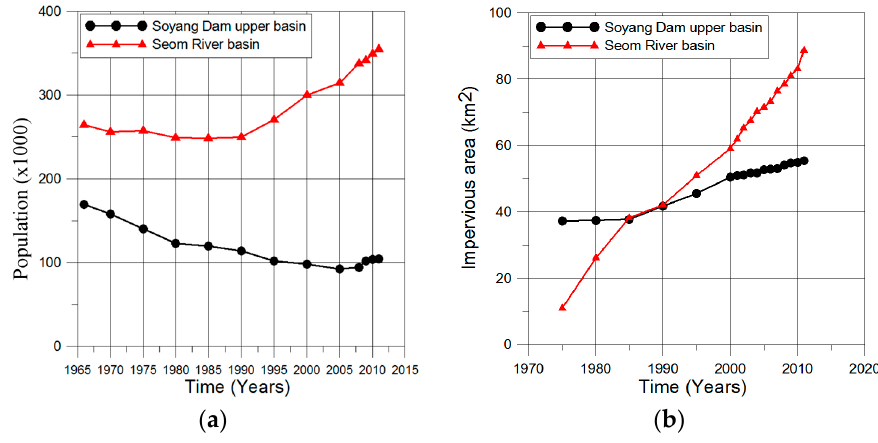
Figure 3. Population and impervious area in two basins. ( a ) Populations; ( b ) impervious area.